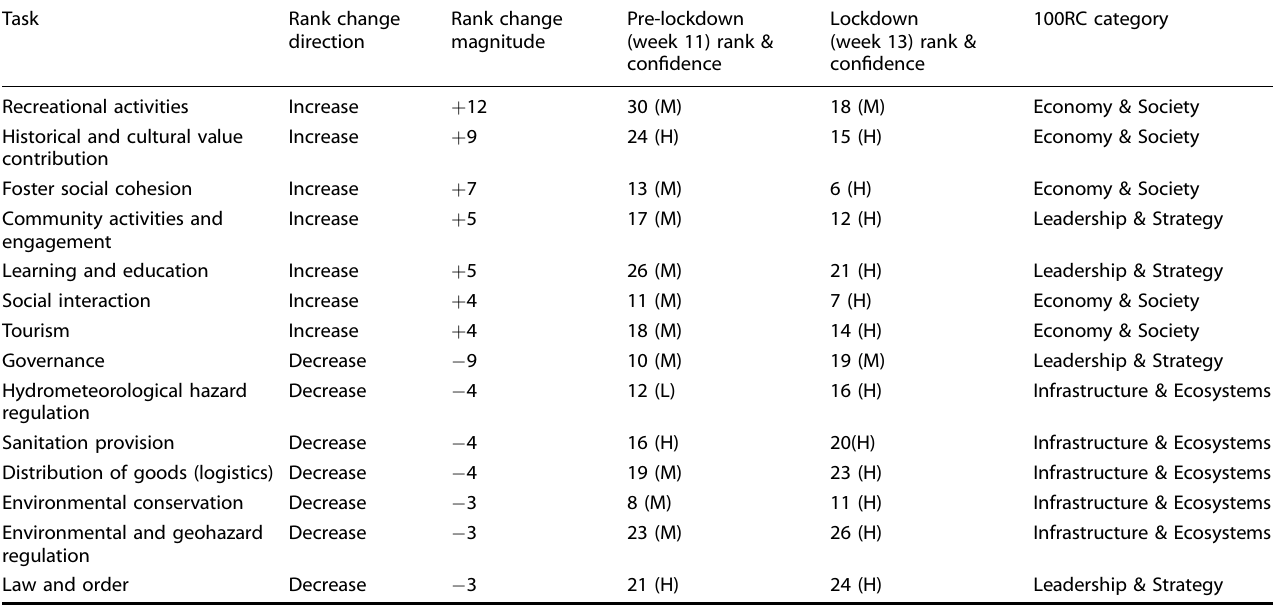
Table 3. Tasks with large magnitude rank changes which were robust to sensitivity analysis, between Phase 2 and Phase